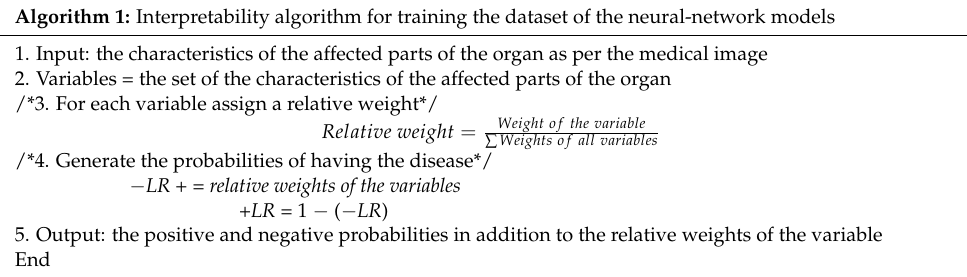
Algorithm 1: Interpretability algorithm for training the dataset of the neural-network